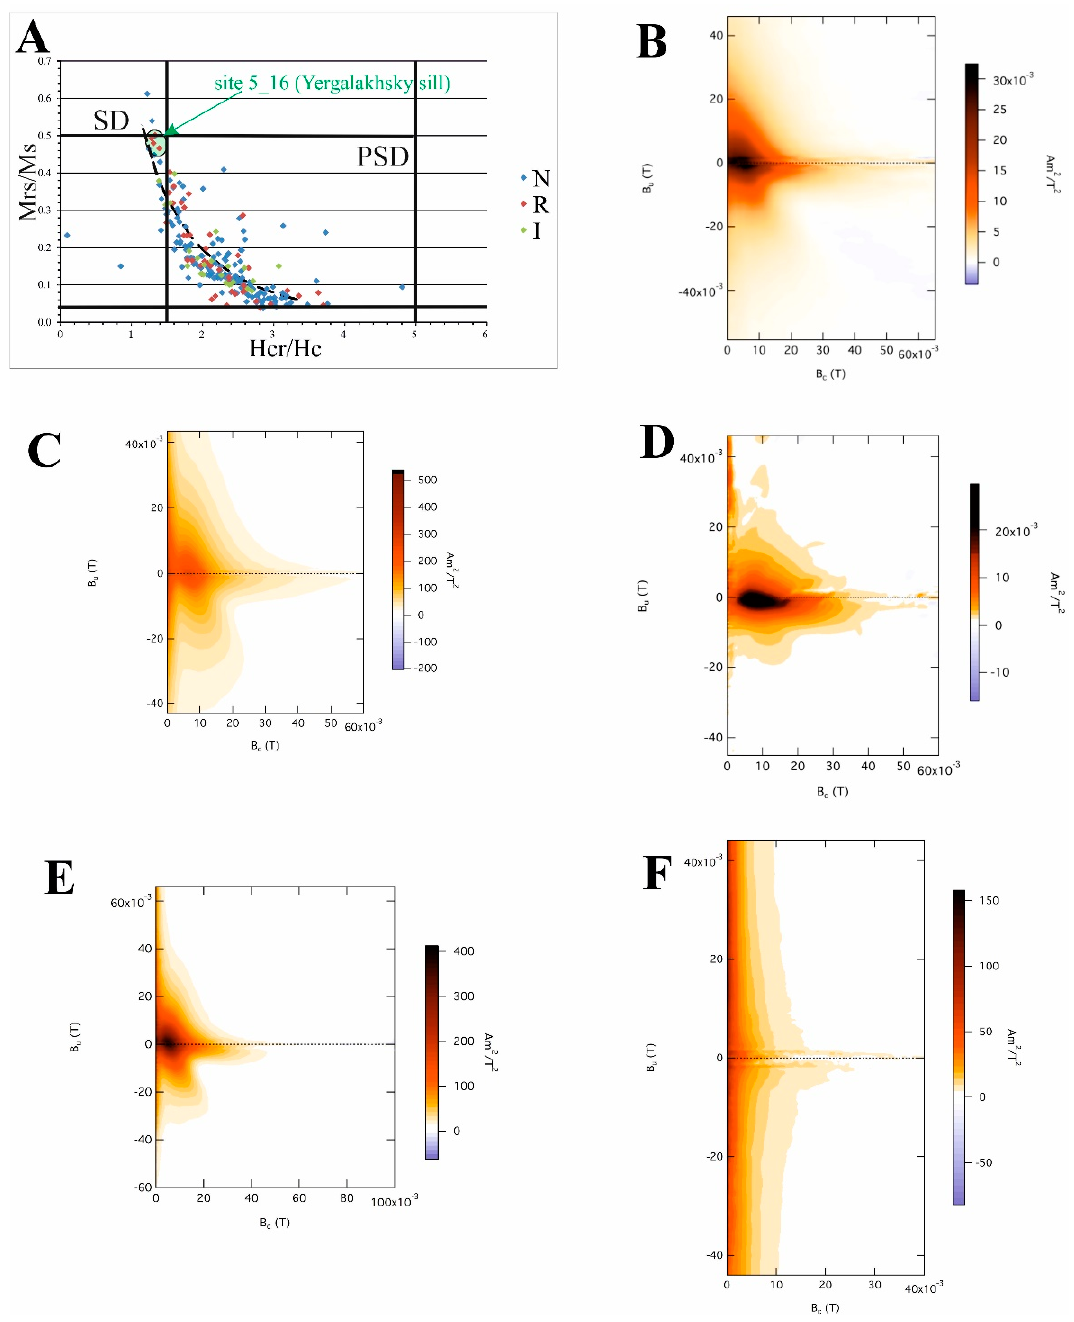
Figure 6. ( A ) Day–Dunlop plot. Sites with N-, R-, and I-types of magnetic fabric are shown in different colors. SD—single-domain; PSD—pseudo-single-domain; Ms—saturation magnetization; Mrs—remanent magnetization; Hc—coercive force; Hcr—remanent coercive force. ( B – F ) Representative FORC-diagrams. ( B ) Sample 295, site mk13_19, basalts of the Mokulaevsky Formation. ( C ) Sample 302, site 12.2_17, leucogabbro of the Zayachiy Creek intrusion. ( D ) Sample 427, site 19_19,